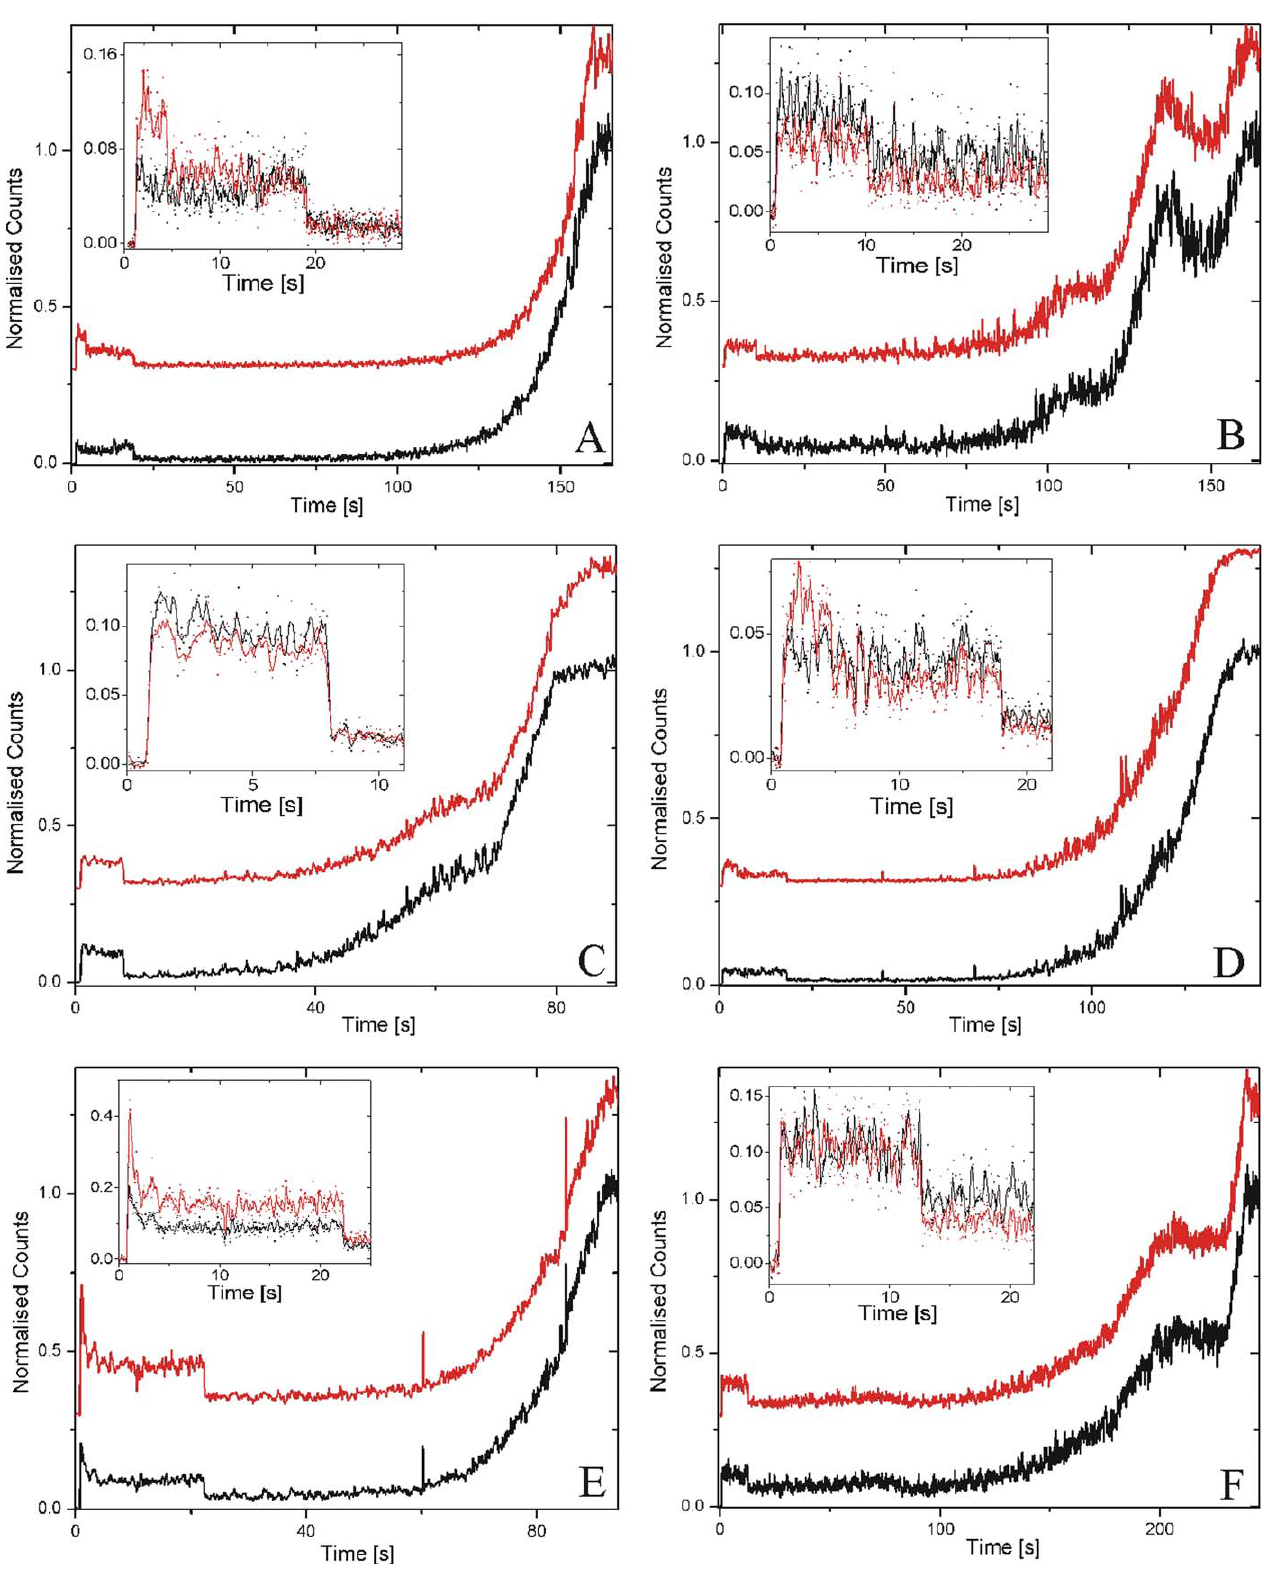
Figure 6. Fluorescence Signal from Packaging Complexes The graphs show the fluorescence intensity of vertical (black) and horizontal (red) polarization detected simultaneously. One example for each of the six investigated mutants is shown. The data were recorded with an integration time of 75 ms and three-points smoothing was applied. The camera background (closed shutter) was subtracted. The signal was normalized using the fluorescence intensity of the bead after packaging was completed. The traces are vertically shifted for clarity. The inset shows a zoom of the data. Here, the unfiltered data is displayed (scatter) together with the three-